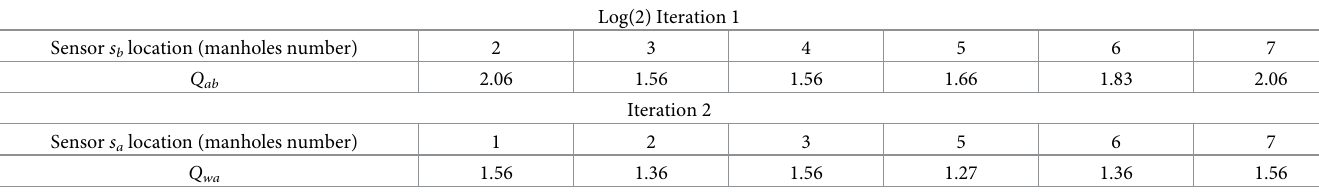
located a a and Q associated wa ab = log ab